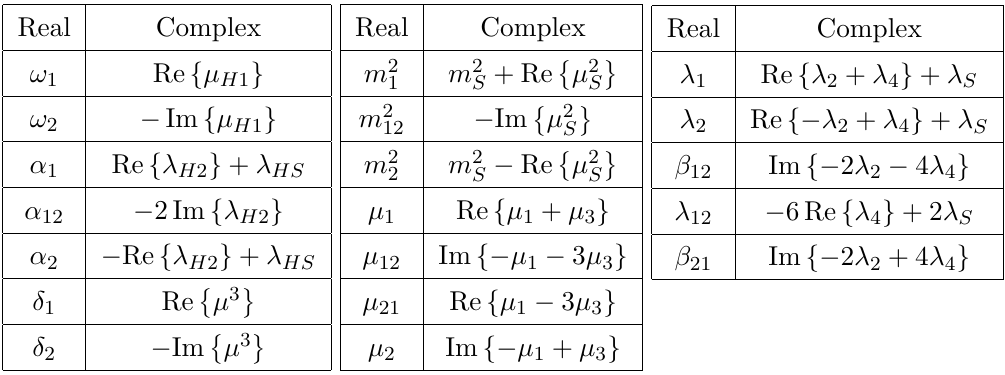
Table 3. Correspondence between the couplings in the real and complex